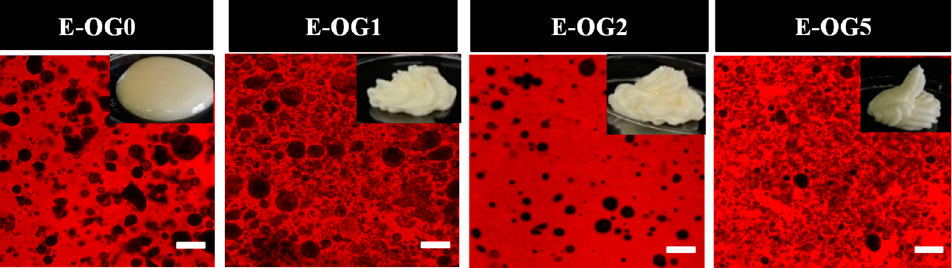
Figure 4. Macro-morphology and Microstructures of W/O emulsions with different content of GMS.